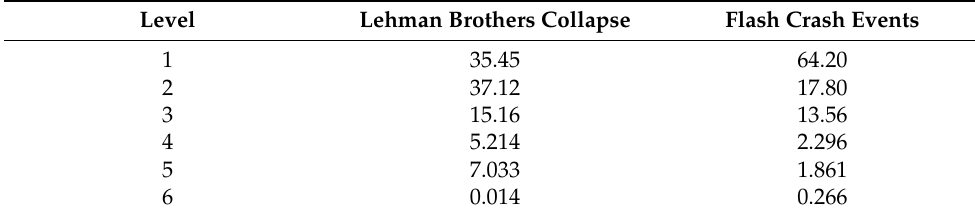
Table 9. Total energy for XOM stock market data.